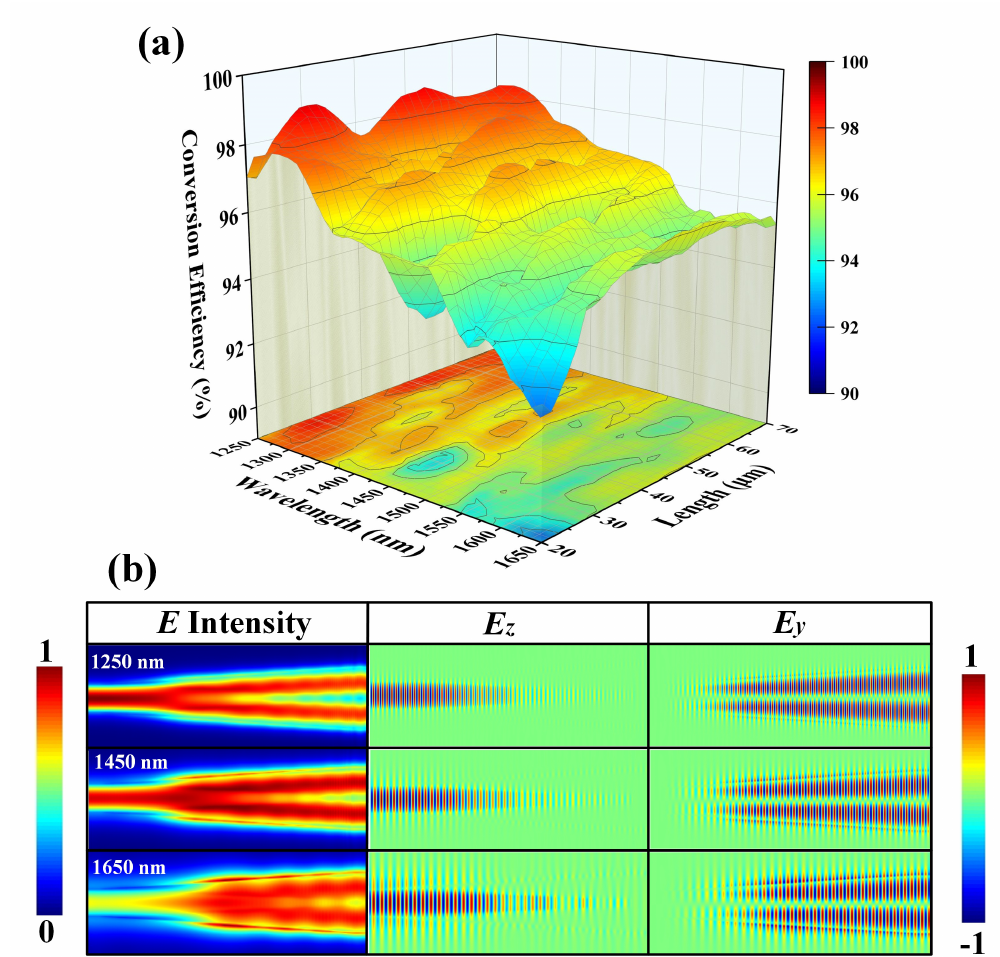
Figure 2. ( a ) Calculated conversion efficiency over a bandwidth of 1250–1650 nm for different lengths from 20 µ m to 70 µ m. ( b ) Optical power distribution and the modal field evolution along the propagation axis of the APR at the wavelengths of 1250 nm, 1450 nm, and 1650